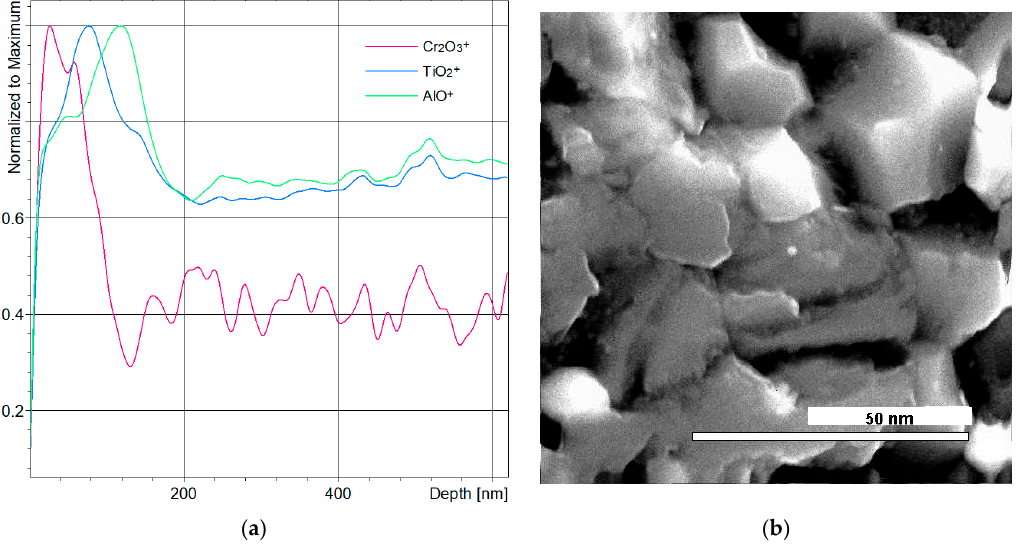
Figure 3. Depth profile of phase distribution in the oxide film on the TiAlCrSiYN/TiAlCrN coating after 45 min of annealing at a temperature of 700 °C ( a ). SEM image of the oxide surface ( b ). The 3D distribution of the titanium, chromium, and aluminum oxides in Figure 4 shows that during annealing, multilayer protective films were formed on the surface of the material. Cr 2 O 3 was formed first, followed by TiO 2 , and, finally, Al 2 O 3 . Further studies on the redistribution of Si and Y were carried out on an equilibrium oxide film. The sur- face oxide was completely removed from the sample by ion etching to avoid the im- plantation of oxygen into the sample. Figure 5 shows the depth distributions of Si and Y in the initial state and after annealing for 45 min. The zero point on the depth axis in Figure 5 corresponds to a true distance of 140 nm from the sample surface.